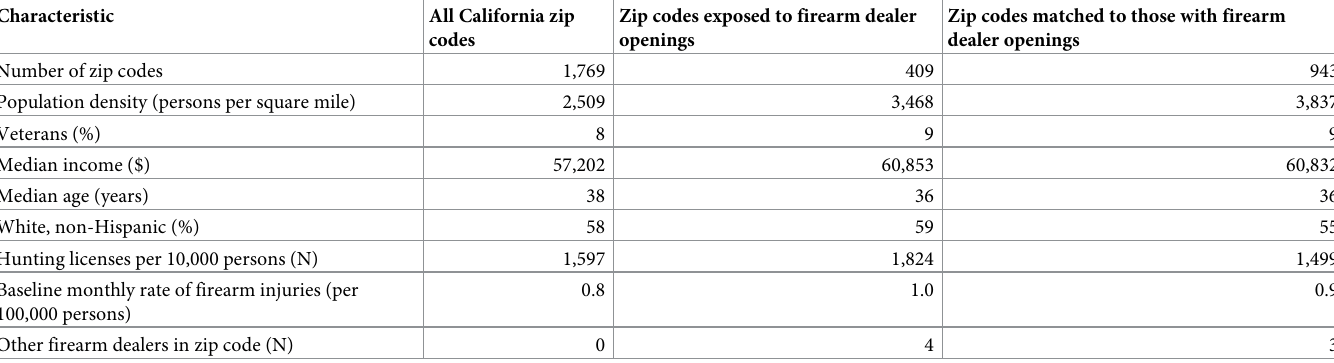
Table 2. Comparison of median values of characteristics of communities exposed to firearm dealer openings versus matched comparison